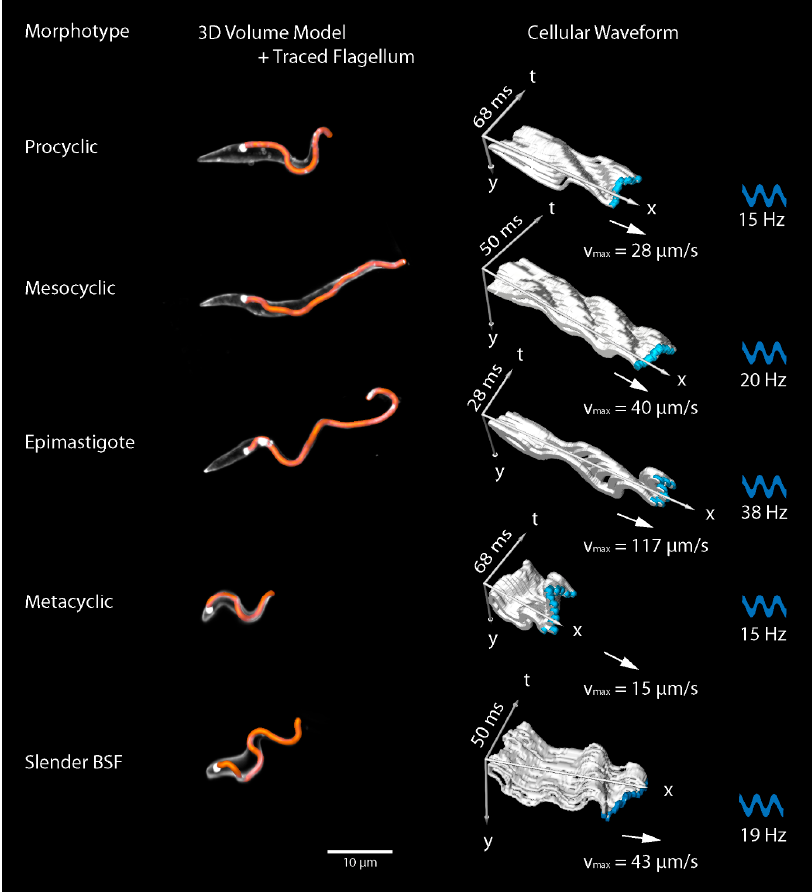
Figure 4. Selected T. b. brucei morphotypes and dynamic cellular waveforms. Major developmental stages are shown, representing pivotal transitions in the parasite´s life cycle. The development from procyclic cells to metacyclic cells takes place in the tsetse fly. Metacyclic cells are injected into mammals and transform into the blood dwelling forms. The left column depicts 3D volume models from fluorescently surface stained, fixed cells. The cell membrane signal allows to trace the course of the attached flagellum around the cell body. These data assess the chirality of the microswimmers and allow the interpretation of their basic rotational motility mode. The morphology correlates with the characteristic swimming behaviours of the different stages. The right column represents traces from high speed recordings of forward swimming cells of the corresponding morphotype. The two-dimensional silhouettes of the cells from successive frames (4 ms resolution) are combined to produce a three-dimensional visualisation of movement along the time axis, as described in detail in [35]. The resulting kymograph reveals the shape of the travelling wave produced by each flagellar beat. Beat frequency, wave amplitude, and maximal velocity, which are measured directly from the original data, are characteristic for specific cell stages, and in combination with their characteristic elasticity, determine the motile capabilities in various surroundings. Figure modified from [27,35].